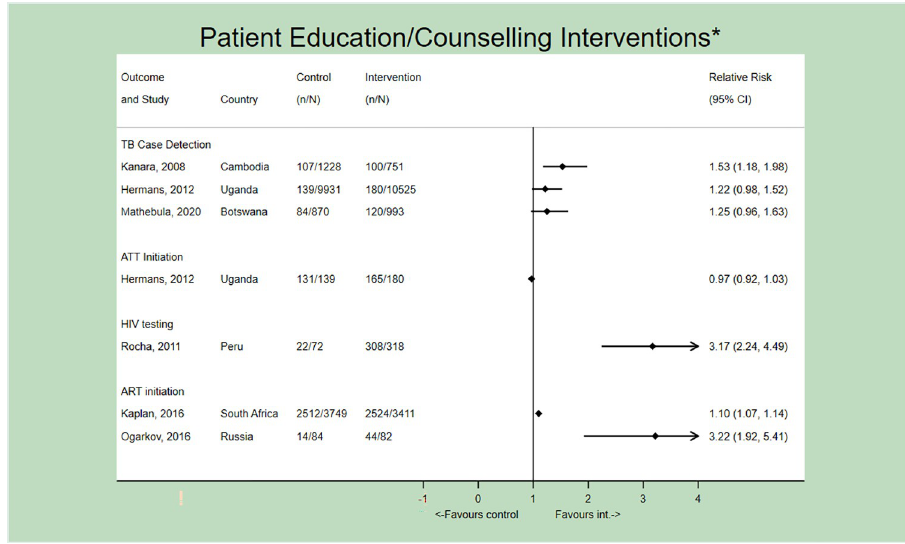
Fig 4. Forest plot (not pooled) depicting the effect of patient education and counselling interventions on all outcomes. � All studies implemented concurrent interventions and/or SOC strategies. Only the first author of each study is listed. ATT = Anti-tuberculosis